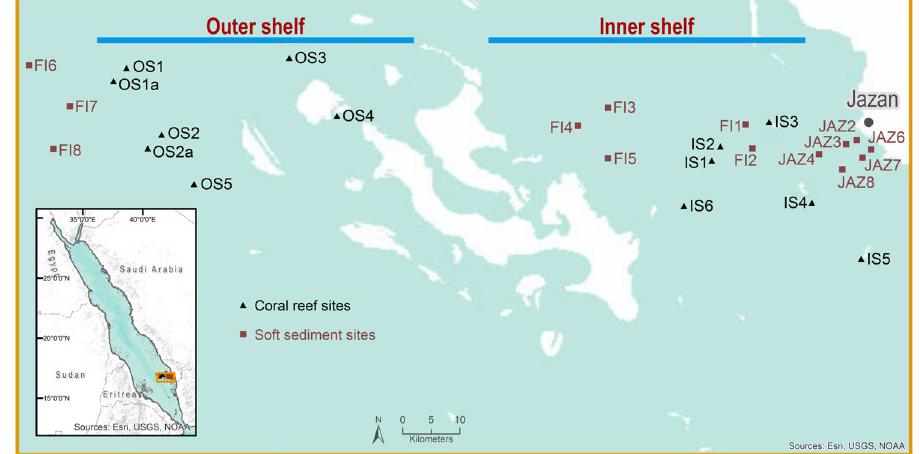
Figure 1. Map showing the location of the reef and soft sediment sites sampled across the Farasan shelf in the southern Red Sea. This figure was created using the ArcGIS software (ArcMap 10.3.1) by ESRI, Inc. (ESRI.com), GEBCO, DeLorme, US Geological Survey (USGS) and the National Oceanic and Atmospheric Administration (NOAA) photo